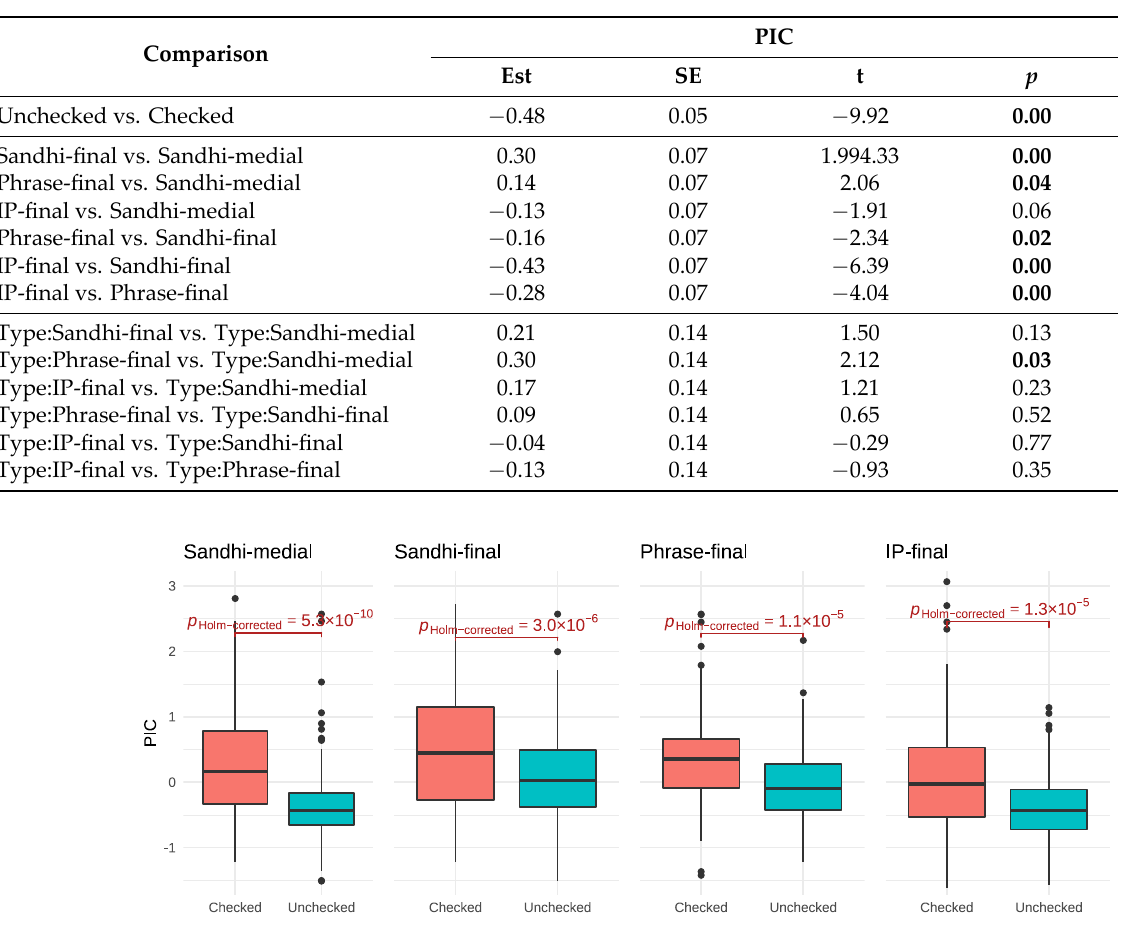
Table 5. Outputs of linear mixed‑effect regression for PIC with interaction effect. Significant p ‑values ( p ⩽ 0.05 ) are marked in bold.